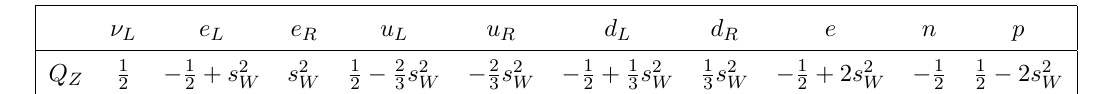
Table 1 . Z charges of Standard Model